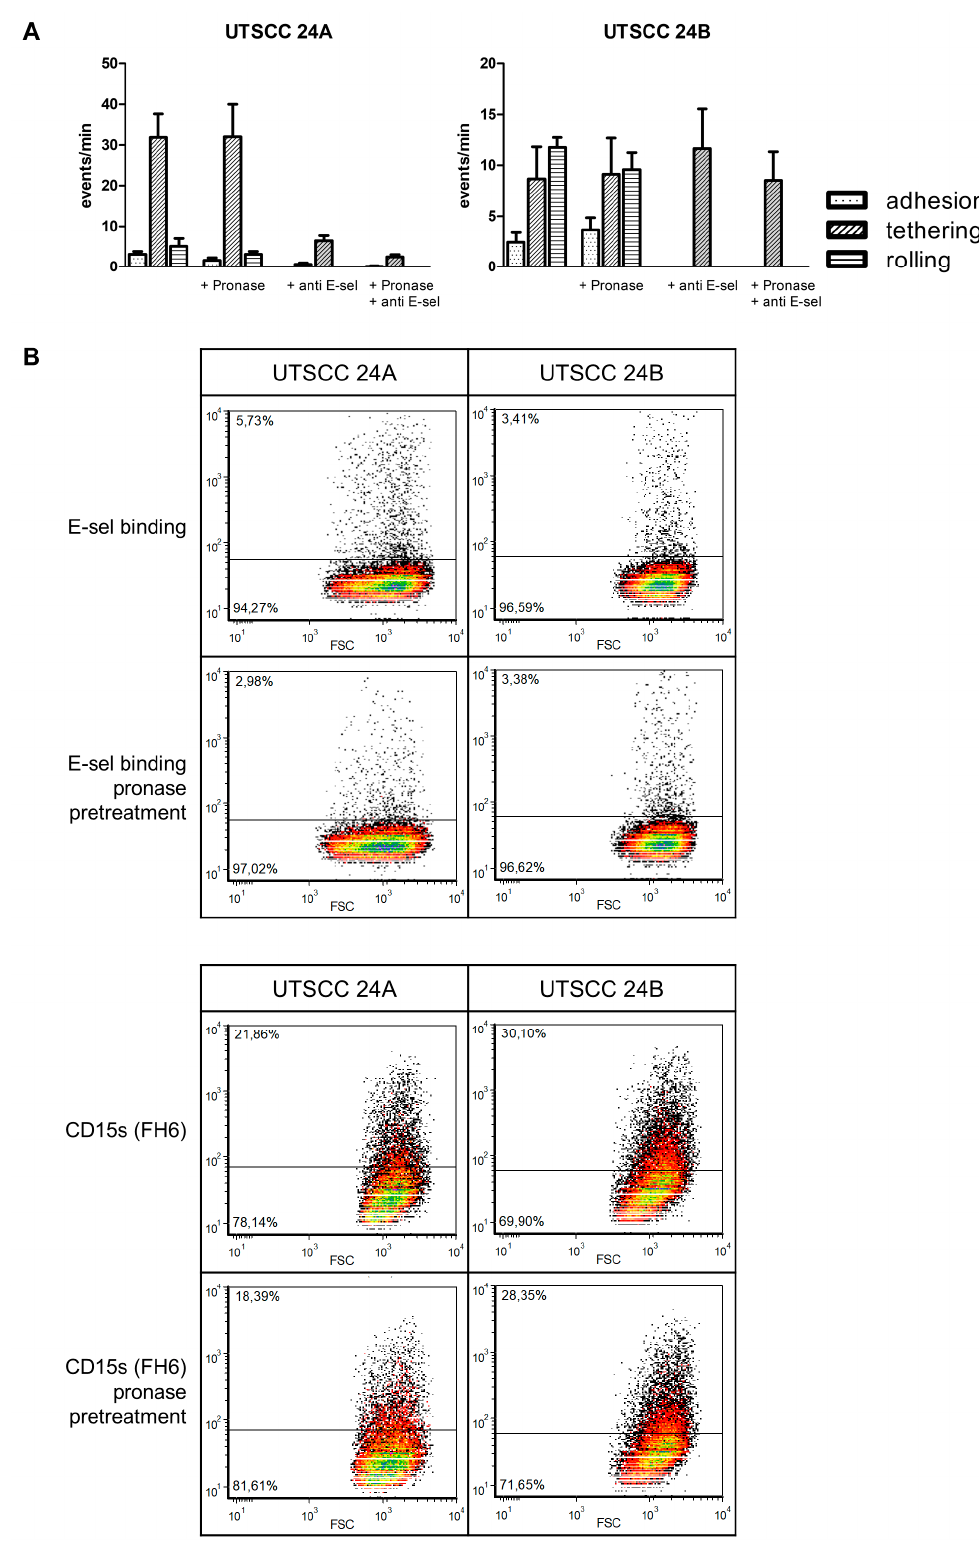
Figure 3. ( A ) Binding of UTSCC 24A and 24B cells to HUVECs with and without pre-incubation with the E-sel antibody was not significantly influenced by proteolytic pretreatment of tumor cells with pronase. ( B ) Pronase treatment slightly reduced static E-selectin binding and CD15s (sLeX) expression in UTSCC 24A, but not in UTSCC 24B cells.